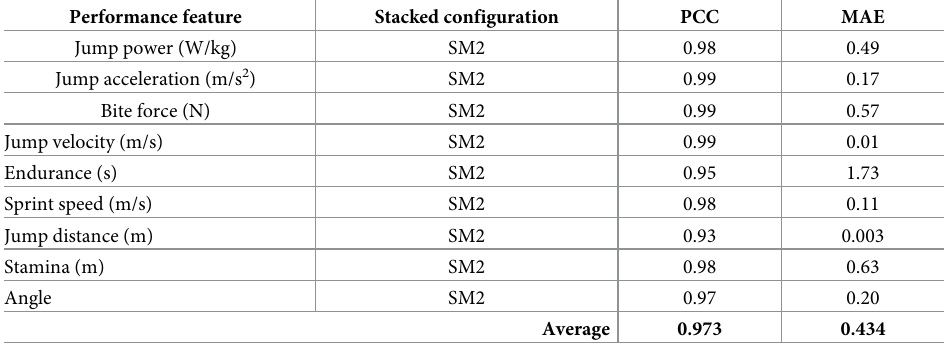
Table 5. Pearson correlation coefficient (PCC) and mean absolute error (MAE) of different stacking models for various performance